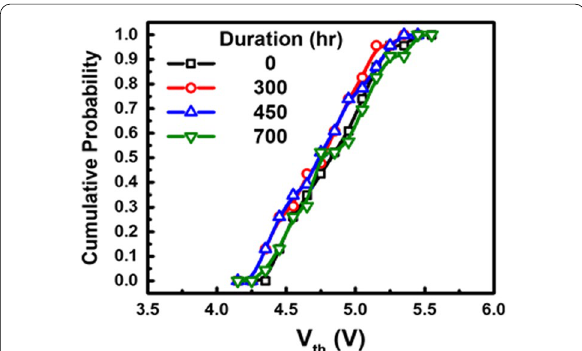
Fig. 11 The data integrity of the stored detection results of 5 mJ/cm